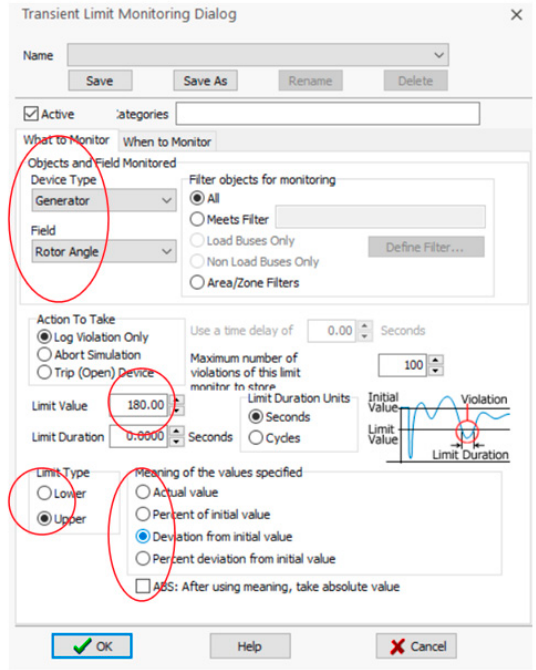
Figure 8. Transient limit monitor setting for CCT study.